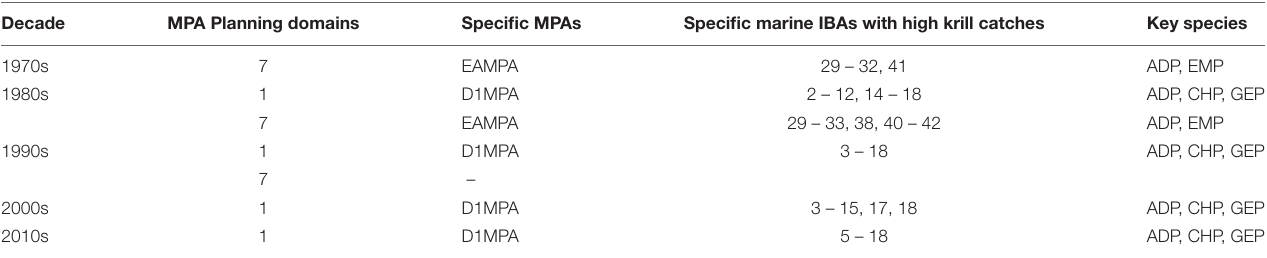
TABLE 6 | Key MPA management units and species of relevance in relation to the marine IBAs and krill fisheries operations within the study area where high krill biomass catches occurred per decade.